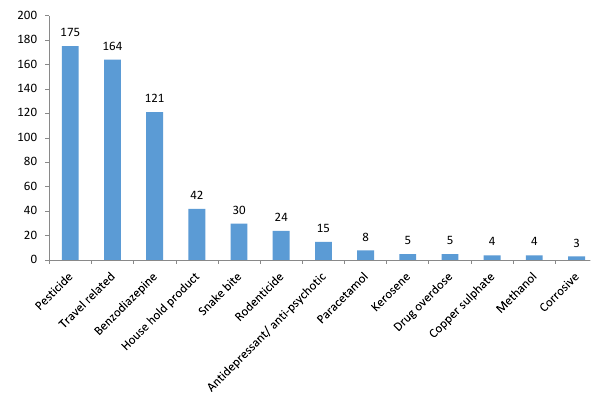
Figure 1. Name of poisoning agents (n = 600).